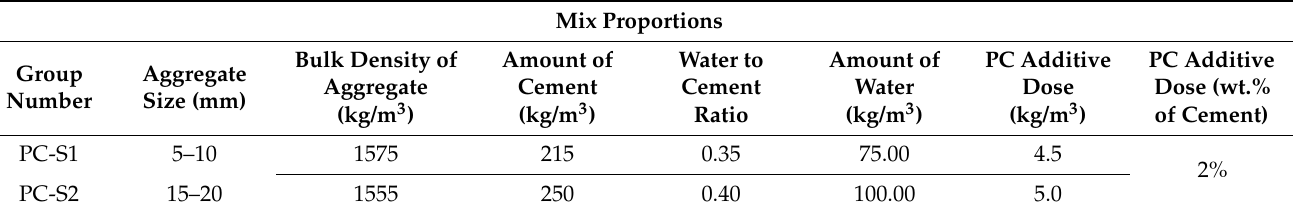
Table 3. Mix proportions of planting concrete (1 m 3